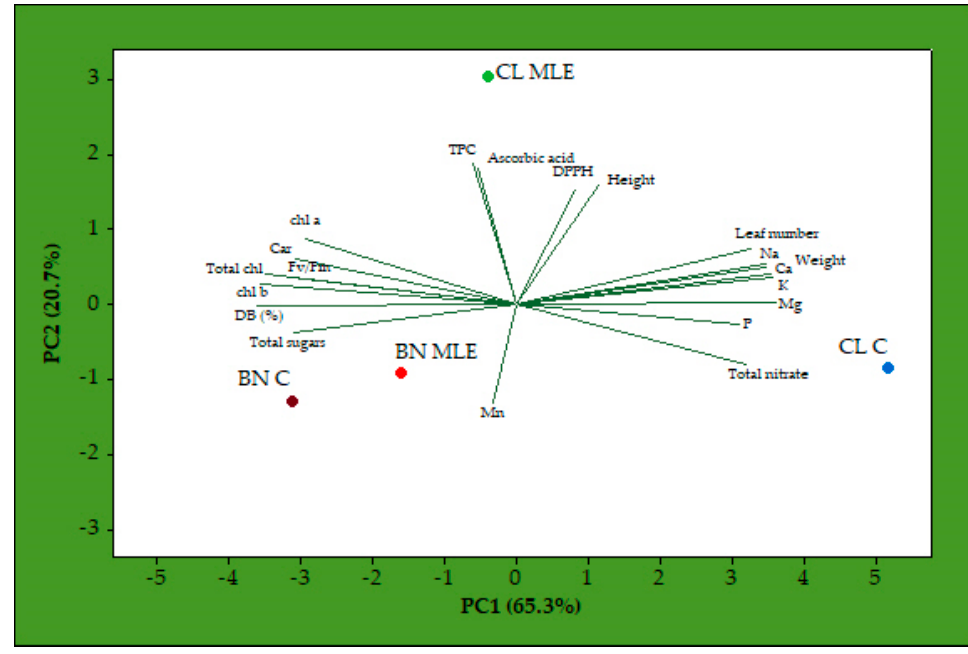
Figure 6. Principal component loading plot and scores of principal component analysis (PCA) of morphometric and nutraceutical traits of BN and CL response to MLE treatment. morphometric and nutraceutical traits of BN and CL response to MLE